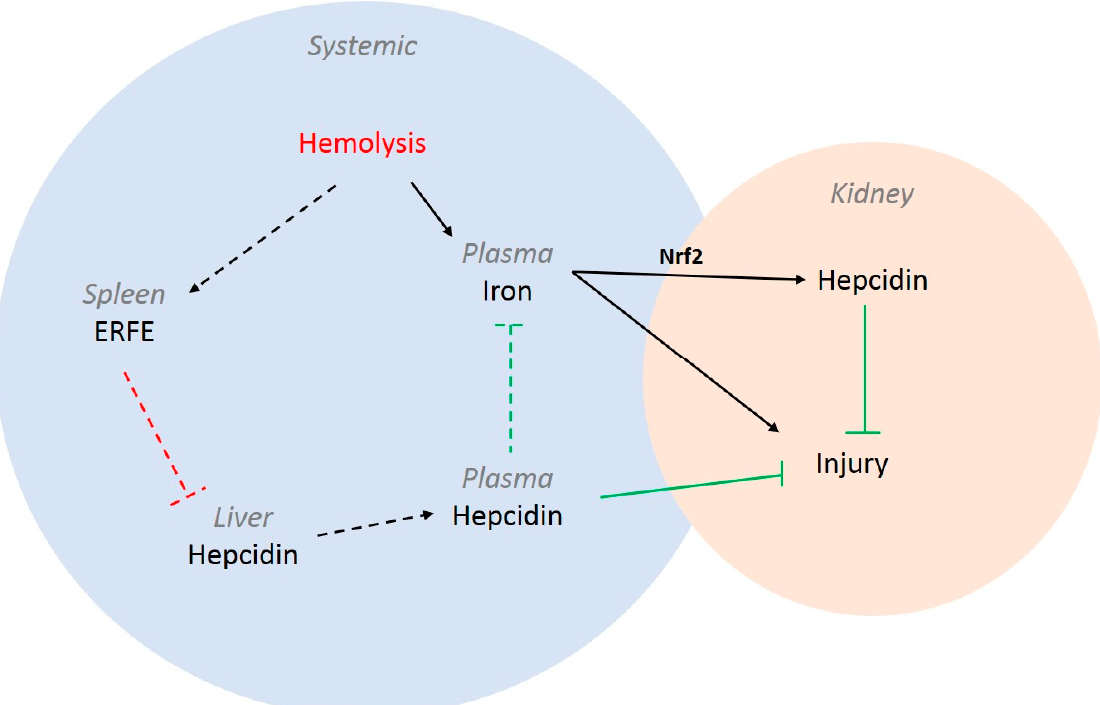
Figure 5. Schematic overview of intertwined systemic and kidney iron handling during hemolysis- induced AKI. Systemic hemolysis results in increased circulating iron levels that are deposited in the kidney, causing acute injury. In parallel, iron can induce kidney hepcidin synthesis through the Nrf2 pathway, which can protect against iron-mediated injury. On a systemic level, hemolysis can activate splenic ERFE production that, in turn, inhibits hepatic hepcidin synthesis, thereby reducing circulating plasma hepcidin levels. Plasma hepcidin can also contribute to kidney protection against injury. Solid lines represent data from this or previous studies on hemolytic kidney injury; dotted arrows represent our hypothesis in the context of hemolysis-mediated AKI. Black lines indicate induction, red lines indicate inhibition, and green lines indicate protection.